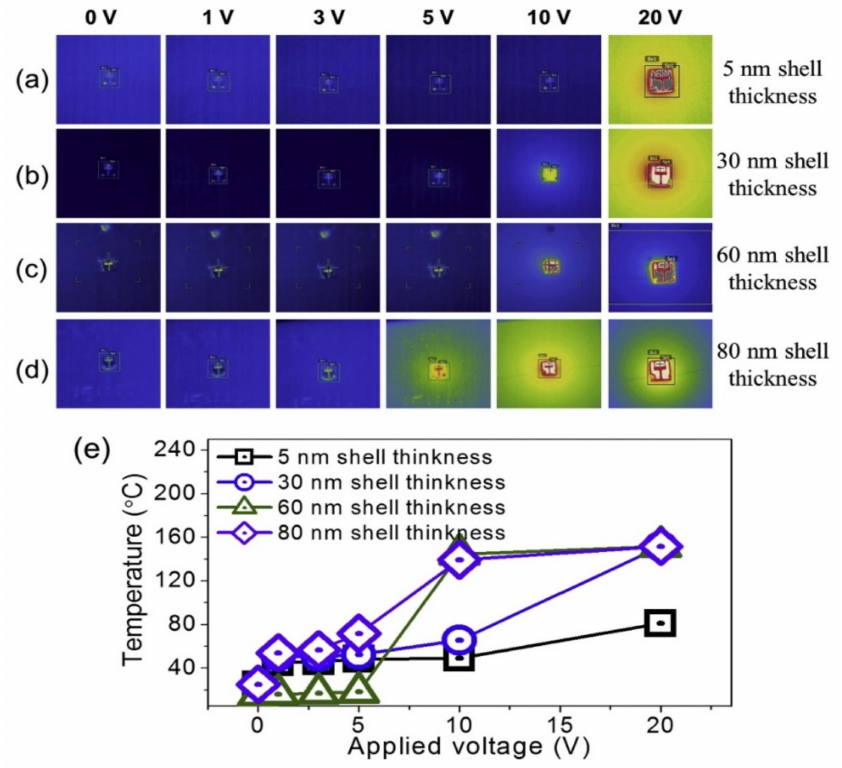
Figure 6. ( a – d ) Thermographs of CuO-functionalized SnO 2 –ZnO core–shell NW sensors with varied shell thicknesses of 5, 30, 60, and 80 nm, respectively, at different applied voltages; ( e ) equivalent plot of temperature as a function of applied voltage of gas sensors. Reprinted from [76] with permission from Elsevier.